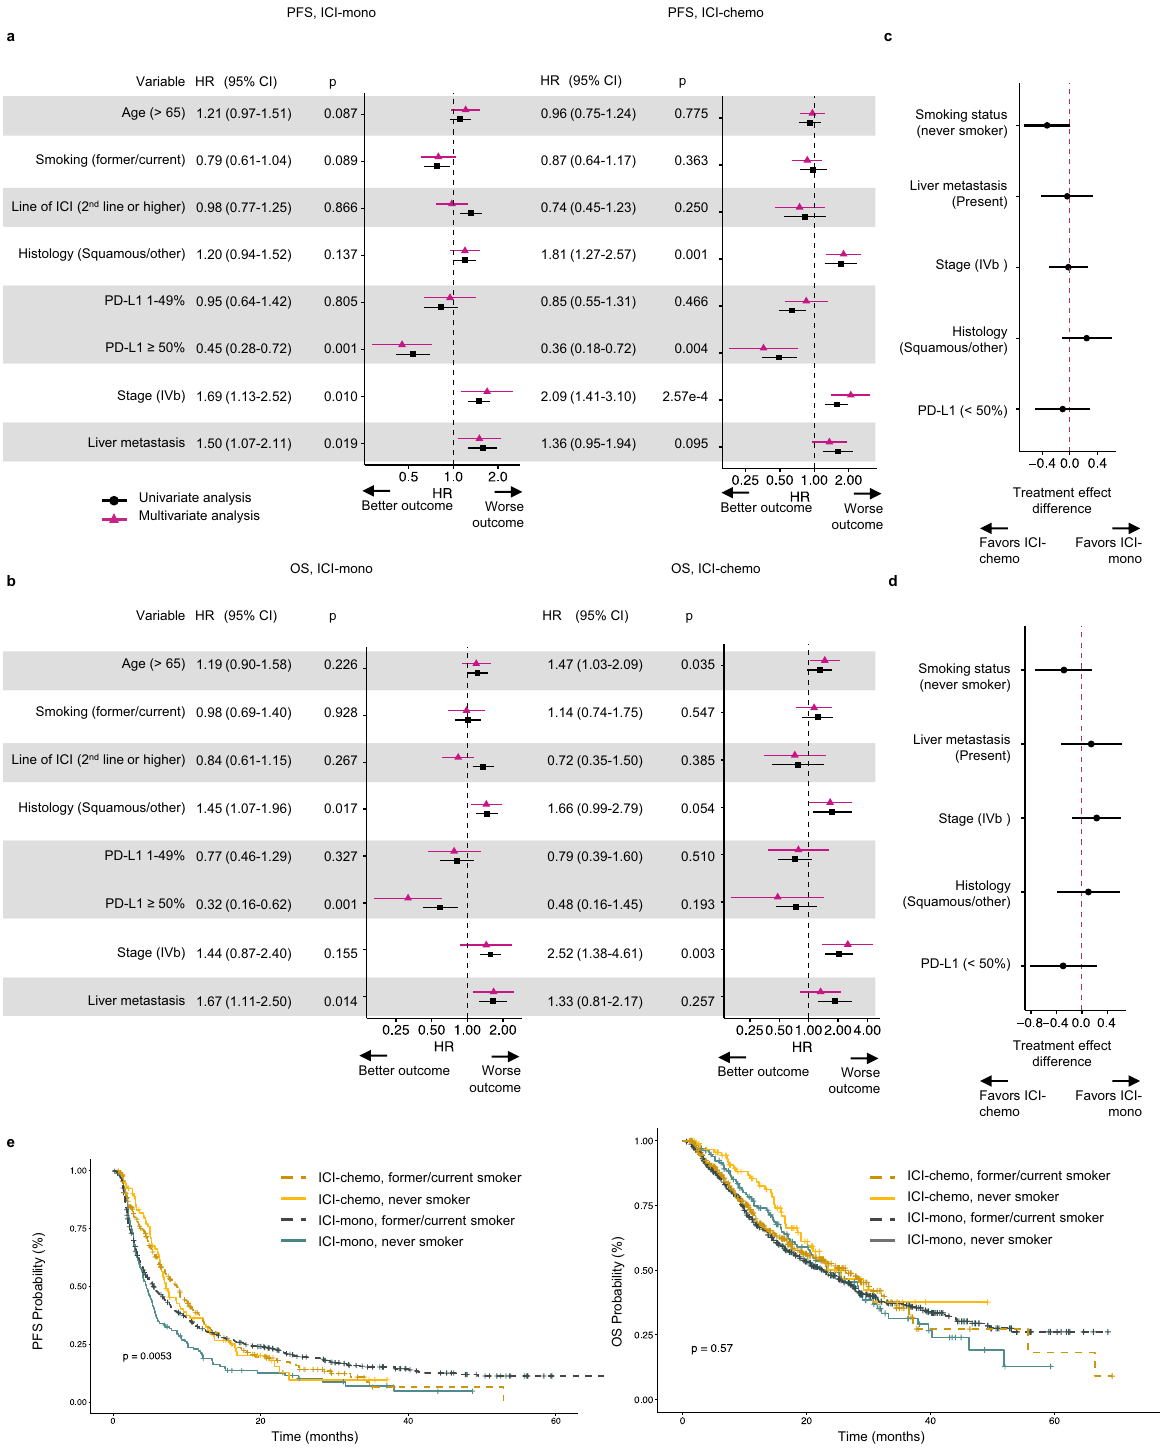
Fig.3|Clinicopathologicalpredictorsofoutcomebytreatmentstrategyinthe MDACC primary cohort ( n =1133). Forest plot of clinicopathologic variables and association with a , progression-free survival (PFS) and b , overall survival (OS) on univariate (black) and multivariate (pink) analysis, strati fi ed by ICI-monotherapy (ICI-mono, left panel) and ICI-chemotherapy (ICI-chemo, right panel). Data are presentedasthehazardratiowitherrorbarsshowing95%con fi denceinterval.Cox proportionalhazardsregressionmodelswereappliedtocalculatethehazardratio.